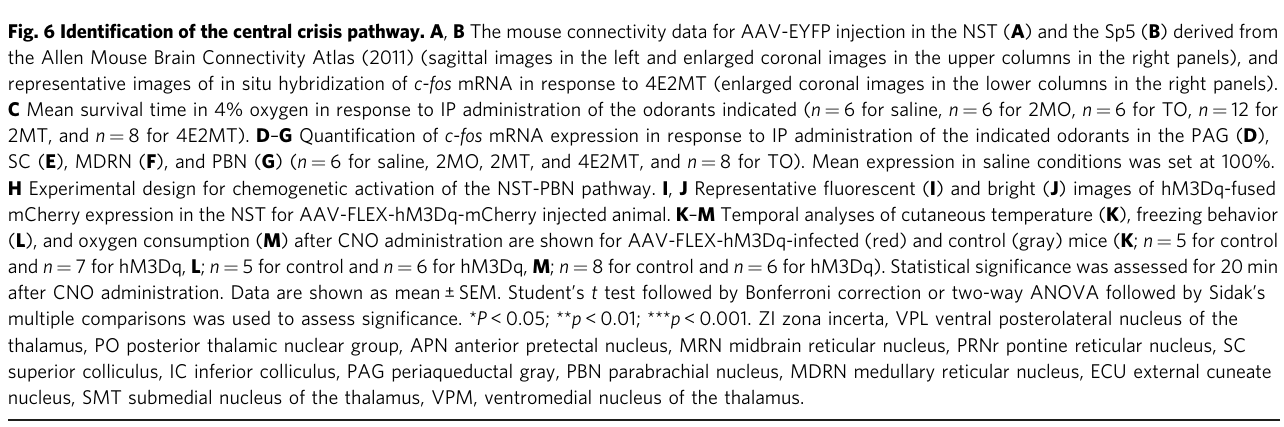
Fig. 6 Identi fi cation of the central crisis pathway. A , B The mouse connectivity data for AAV-EYFP injection in the NST ( A ) and the Sp5 ( B ) derived from the Allen Mouse Brain Connectivity Atlas (2011) (sagittal images in the left and enlarged coronal images in the upper columns in the right panels), and representative images of in situ hybridization of c-fos mRNA in response to 4E2MT (enlarged coronal images in the lower columns in the right panels). C Mean survival time in 4% oxygen in response to IP administration of the odorants indicated ( n = 6 for saline, n = 6 for 2MO, n = 6 for TO, n = 12 for 2MT, and n = 8 for 4E2MT). D – G Quanti fi cation of c-fos mRNA expression in response to IP administration of the indicated odorants in the PAG ( D ), SC ( E ), MDRN ( F ), and PBN ( G ) ( n = 6 for saline, 2MO, 2MT, and 4E2MT, and n = 8 for TO). Mean expression in saline conditions was set at 100%. H Experimental design for chemogenetic activation of the NST-PBN pathway. I , J Representative fl uorescent ( I ) and bright ( J ) images of hM3Dq-fused mCherry expression in the NST for AAV-FLEX-hM3Dq-mCherry injected animal. K – M Temporal analyses of cutaneous temperature ( K ), freezing behavior ( L ), and oxygen consumption ( M ) after CNO administration are shown for AAV-FLEX-hM3Dq-infected (red) and control (gray) mice ( K ; n = 5 for control and n = 7 for hM3Dq, L ; n = 5 for control and n = 6 for hM3Dq, M ; n = 8 for control and n = 6 for hM3Dq). Statistical signi fi cance was assessed for 20 min after CNO administration. Data are shown as mean ± SEM. Student ’ s t test followed by Bonferroni correction or two-way ANOVA followed by Sidak ’